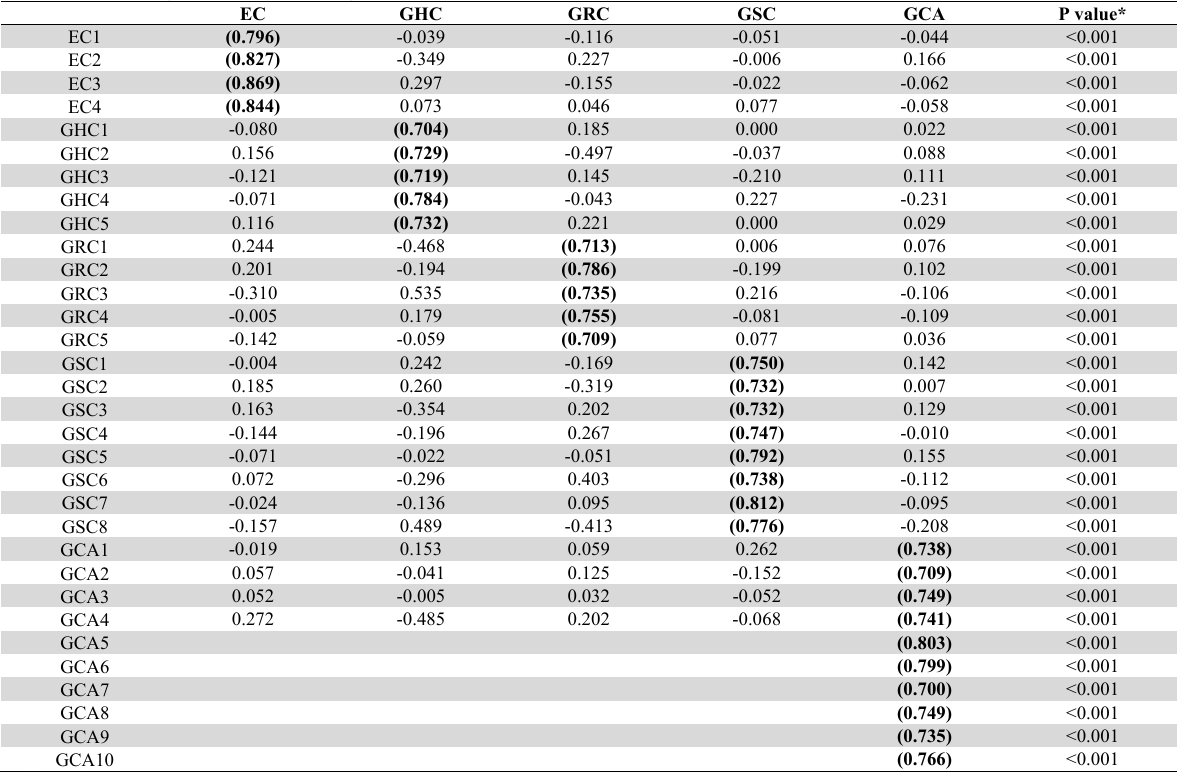
Combined loadings and cross-loadings